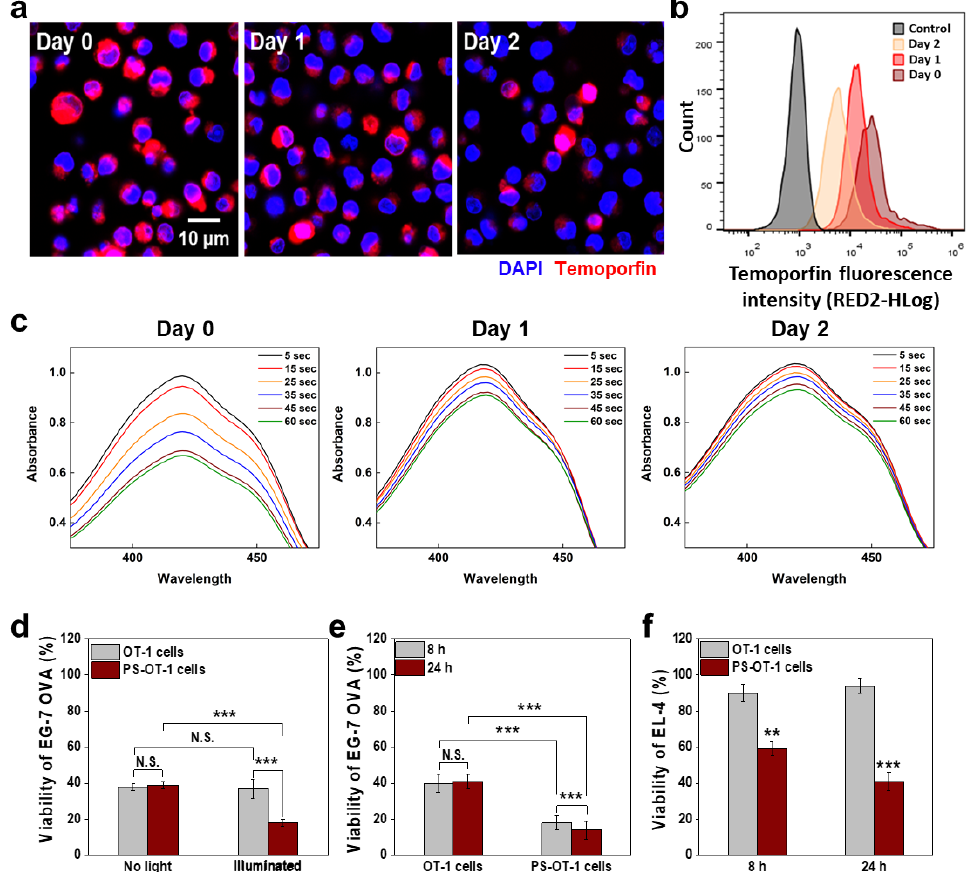
Figure 3. In vitro combinational antitumor effect of PDT and ACT by PS-OT-1 cells. ( a ) Fluorescence images of PS-OT-1 cells after 0, 1 or 2 days of incubation. ( b ) Flow cytometric analysis of PS-OT-1 cells after 0, 1 or 2 days of incubation. ( c ) Extracellular ROS generation of PS-OT-1 cells that were incubated in cell culture media at 37 ◦ C for 2 days. After 6 h of incubation of PS-OT-1 cells at day 1, 2, each cell media was isolated and the extracellular ROS was measured using DPBF bleaching assays. ( d ) Cell viability of EG.7-OVA after incubation with PS-OT-1 cells or unloaded OT-1 cells in presence or absence of the light irradiation. ( e ) Cell viability of EG.7-OVA after incubation with PS-OT-1 cells or unloaded OT-1 cells after 8 or 24 h of incubation. ( f ) Cell viability of EL-4 cells after incubation with PS-OT-1 cells or unloaded OT-1 cells. The asterisks in figures indicate a statistical significance with p value of <0.01 ** and <0.001 ***. N.S. in figures indicate a statistically not